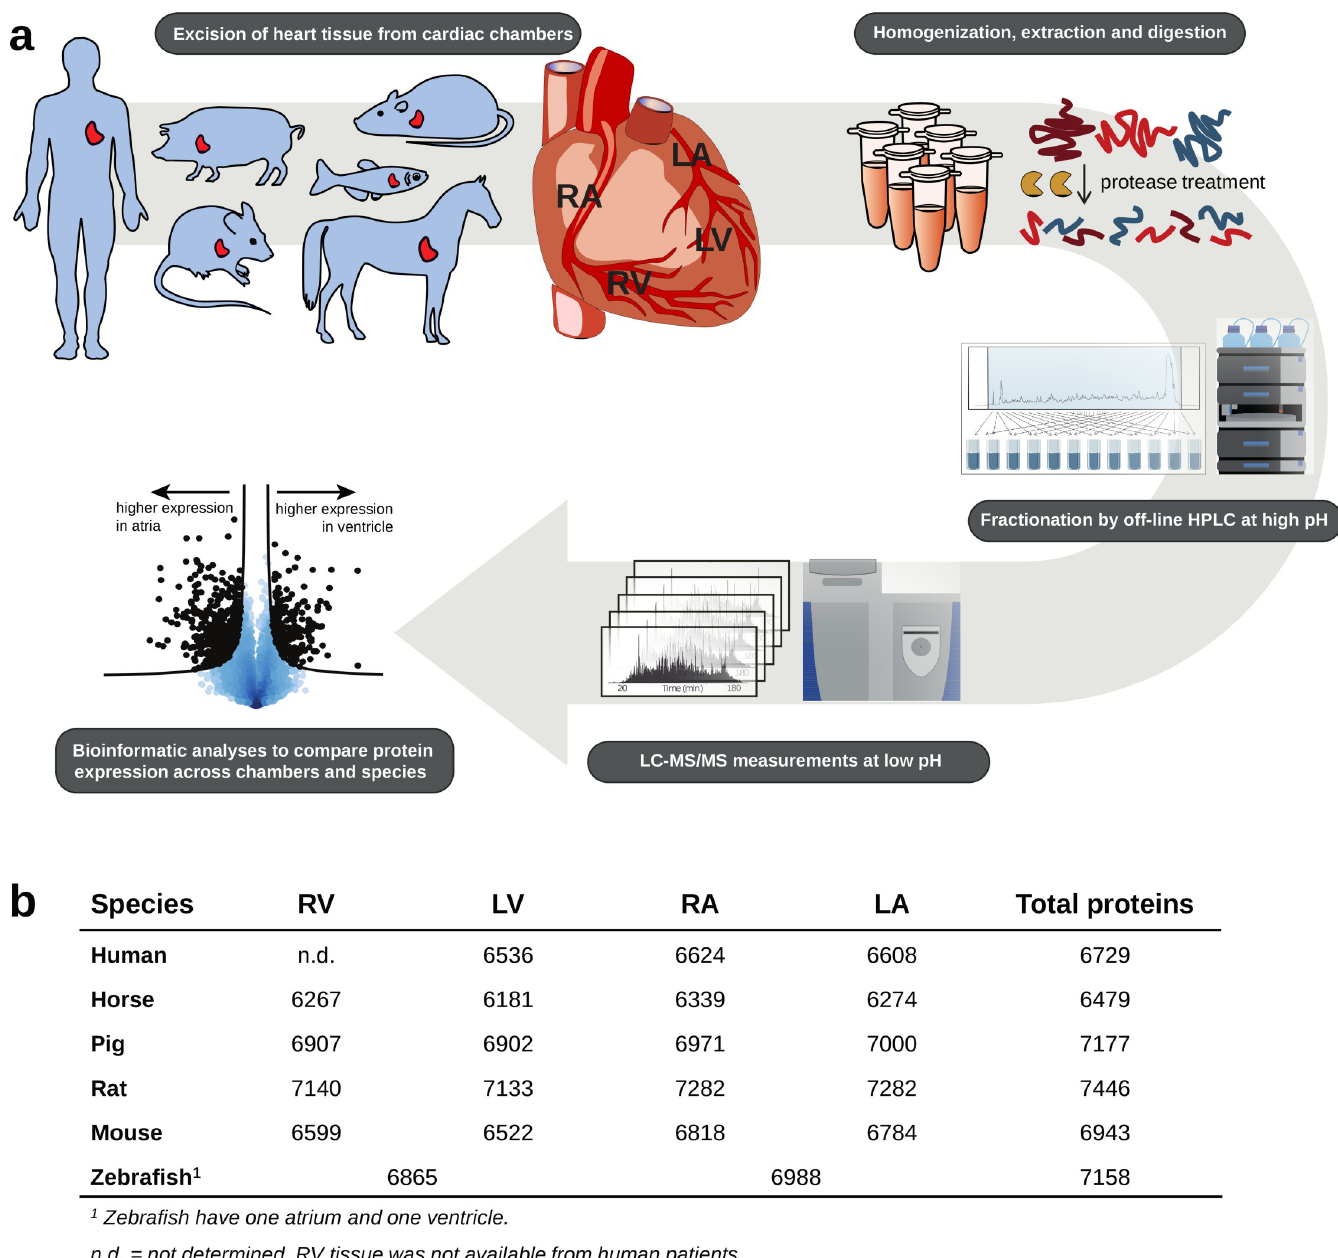
Fig 1. Multispecies proteome mapping across cardiac chambers. (a) Workflow for the determination of chamber-specific cardiac proteomes in human, horse, pig, rat, mouse, and zebrafish. Tissue biopsies were collected in triplicates. Biopsies were homogenized followed by protein extraction and digestion, desalted peptides were then fractionated, and the generated peptide fractions were analyzed by LC–MS/MS. Data were analyzed using MaxQuant and Perseus software. (b) Table summarizing the number of proteins measured in each species across cardiac chambers. H AU : AbbreviationlistshavebeencompiledforthoseusedthroughoutFigs 1 (cid:0) 5 : Pleaseverifyiftheentriesarecorrect : PLC, high-pressure liquid chromatography; LA, left atrium; LC–MS/MS, liquid chromatography tandem mass spectrometry; LV, left ventricle; RA, right atrium; RV, right ventricle.